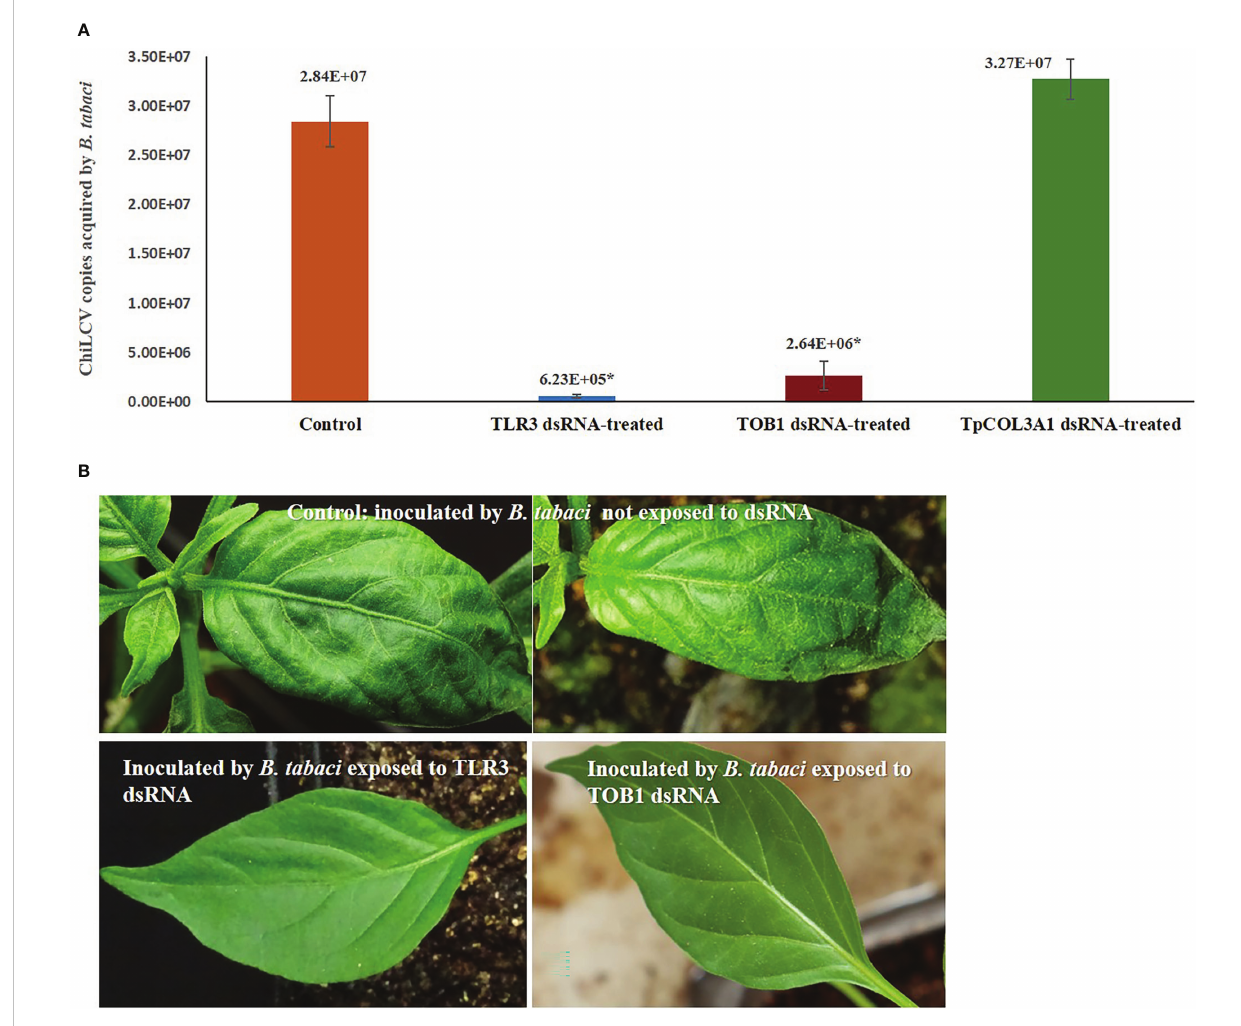
FIGURE 3 Effect of silencing TLR3 and TOB1 on ChiLCV acquisition and transmission by B. tabaci . (A) Mean ChiLCV copy numbers acquired by TLR3 and TOB1 dsRNA-fed B. tabaci . The mean denoted by an asterisk (*) indicates a signi fi cant difference (p< 0.0001). The error bars are the standard error of the mean (SEM). (B) Leaf curl symptoms on chilli plants inoculated by B. tabaci not exposed to dsRNA and exposed to TLR3 and TOB1